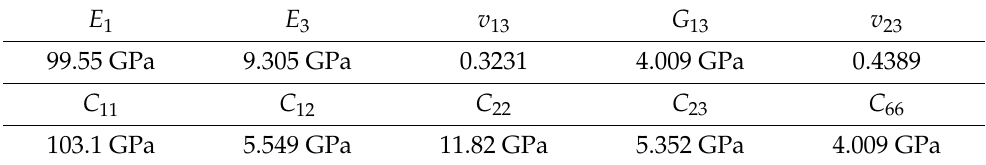
Table 4. Derived stiffness matrix of UD with tensile loading and longitudinal